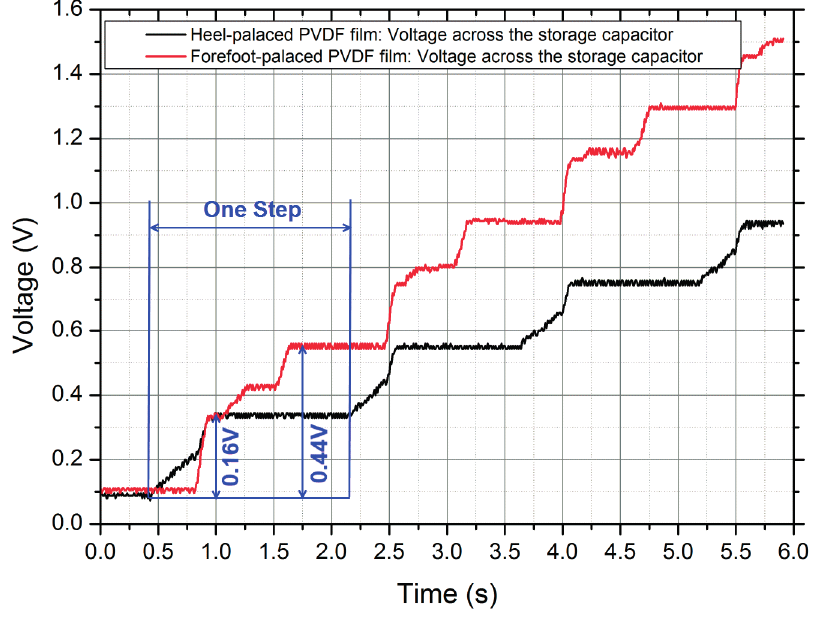
Figure 12. The voltages across the storage capacitors of 25 μ F, the red trace for the forefoot-placed PVDF film, the black trace for the heel-placed PVDF